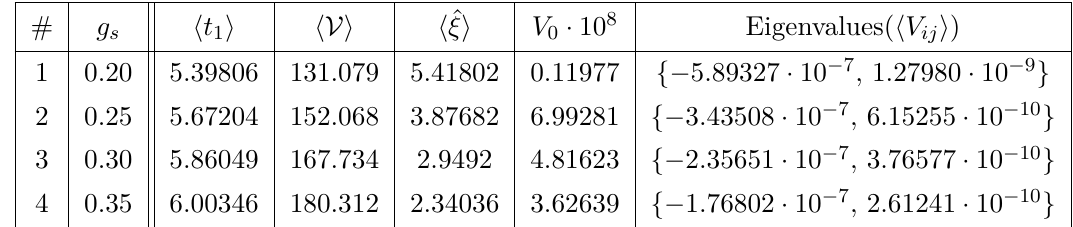
Table 9 . String coupling variation for the α 0 -uplifted tachyonic dS vacua of the Quintic 3-fold M 1 , 5 . The underlying parameters are set as W 0 = − 1 , a 1 = π minimized at h ρ = 0 . 1 i